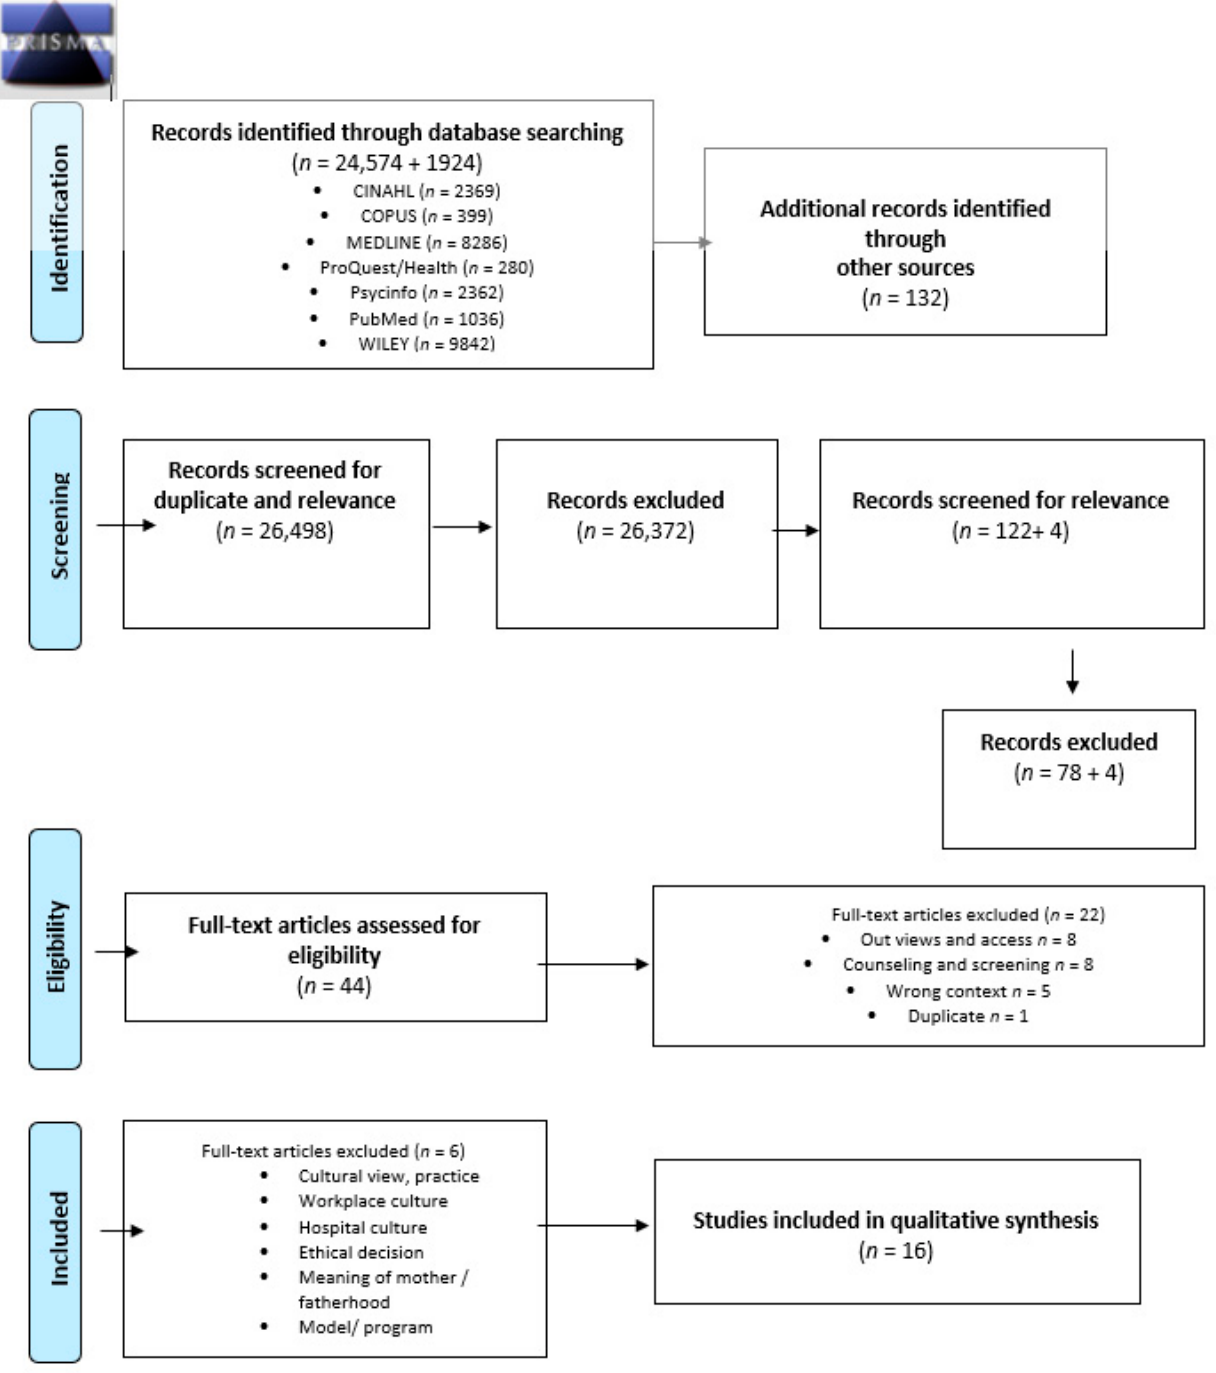
Figure 1. Prisma (2019) Flow Diagram. From: Moher, D.; Liberati, A., Tetzlaff, J., Altman, D.G., the PRISMA Group. Preferred Reporting Items for Systematic Reviews and MetaAnalyses: The PRISMA Statement. PLoS Med 2009 , 6 , e1000097. doi:10.1371/journal.pmed1000097. Available online: www.prisma-statement.org (accessed on 10 May 2021) [52].